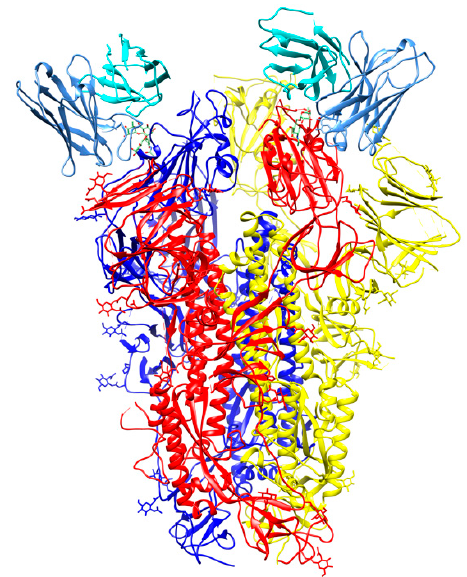
Figure 8. Cryo-Electron Microscopy (Cryo-EM) structure of S309 antibody with the S glycoprotein trimer (PDB id 6wpt). The antibody chains are colored in cyan (L chain) and cornflower blue (H chain). The chains of the S trimer are shown in blue, red, and yellow.